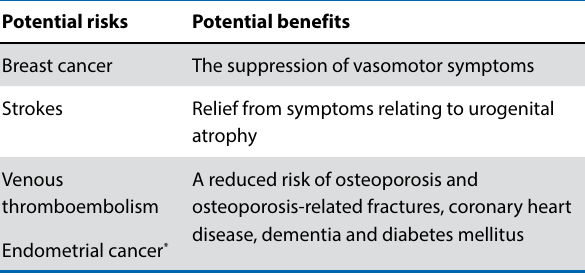
Table 1: Potential risks and benefits of MHT in perimenopausal women